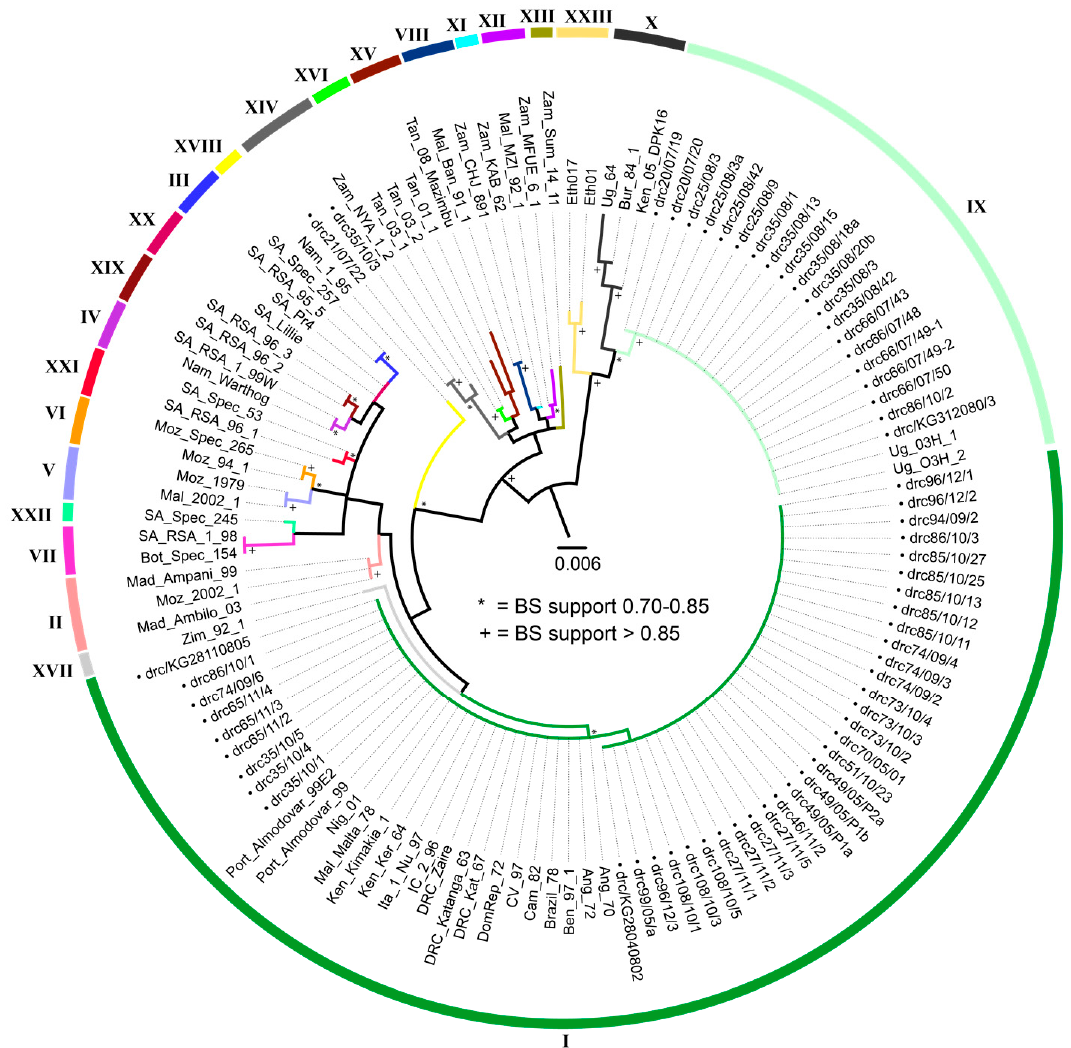
Figure 1. Maximum likelihood tree depicting genetic relationships of strains examined in this study utilizing the p72 locus. Bootstrap support (BS) is indicated by * for values between 75% and 85%, and by + for values greater than 85% support. The scale bar indicates the number of nucleotide substitutions per site. Each color is a different genotype, indicated by the corresponding roman numerals. Labels for all strains generated by this study begin with •drc (Democratic Republic of the Congo). Strains are named in the following manner: Country_Strain Name. Acronyms used for countries of origin are as follows: Ang=Angola, Ben=Benin, Bot=Botswana, Bra=Brazil, Bur=Burundi, Cam=Cameroon, CV=Cape Verde, Dom Rep=Dominican Republic, the DRC=Democratic Republic of Congo, IC=Ivory Coast, Ita=Italy, Ken=Kenya, Mad=Madagascar, Mal=Malawi, Malt=Malta, Moz=Mozambique, Nam=Namibia, Nig=Nigeria, Port=Portugal, SA=South Africa, Tan=Tanzania, Ug=Uganda, Zam=Zambia, Zimb=Zimbabwe.